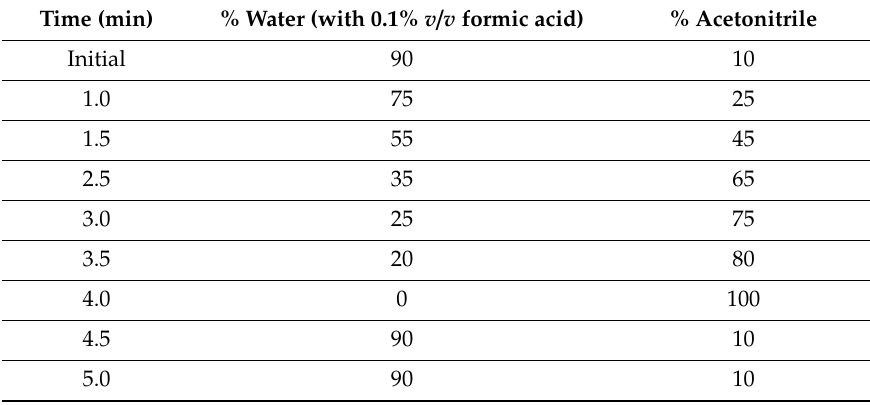
Table 3. A mobile phase gradient program for the LC-MS / MS